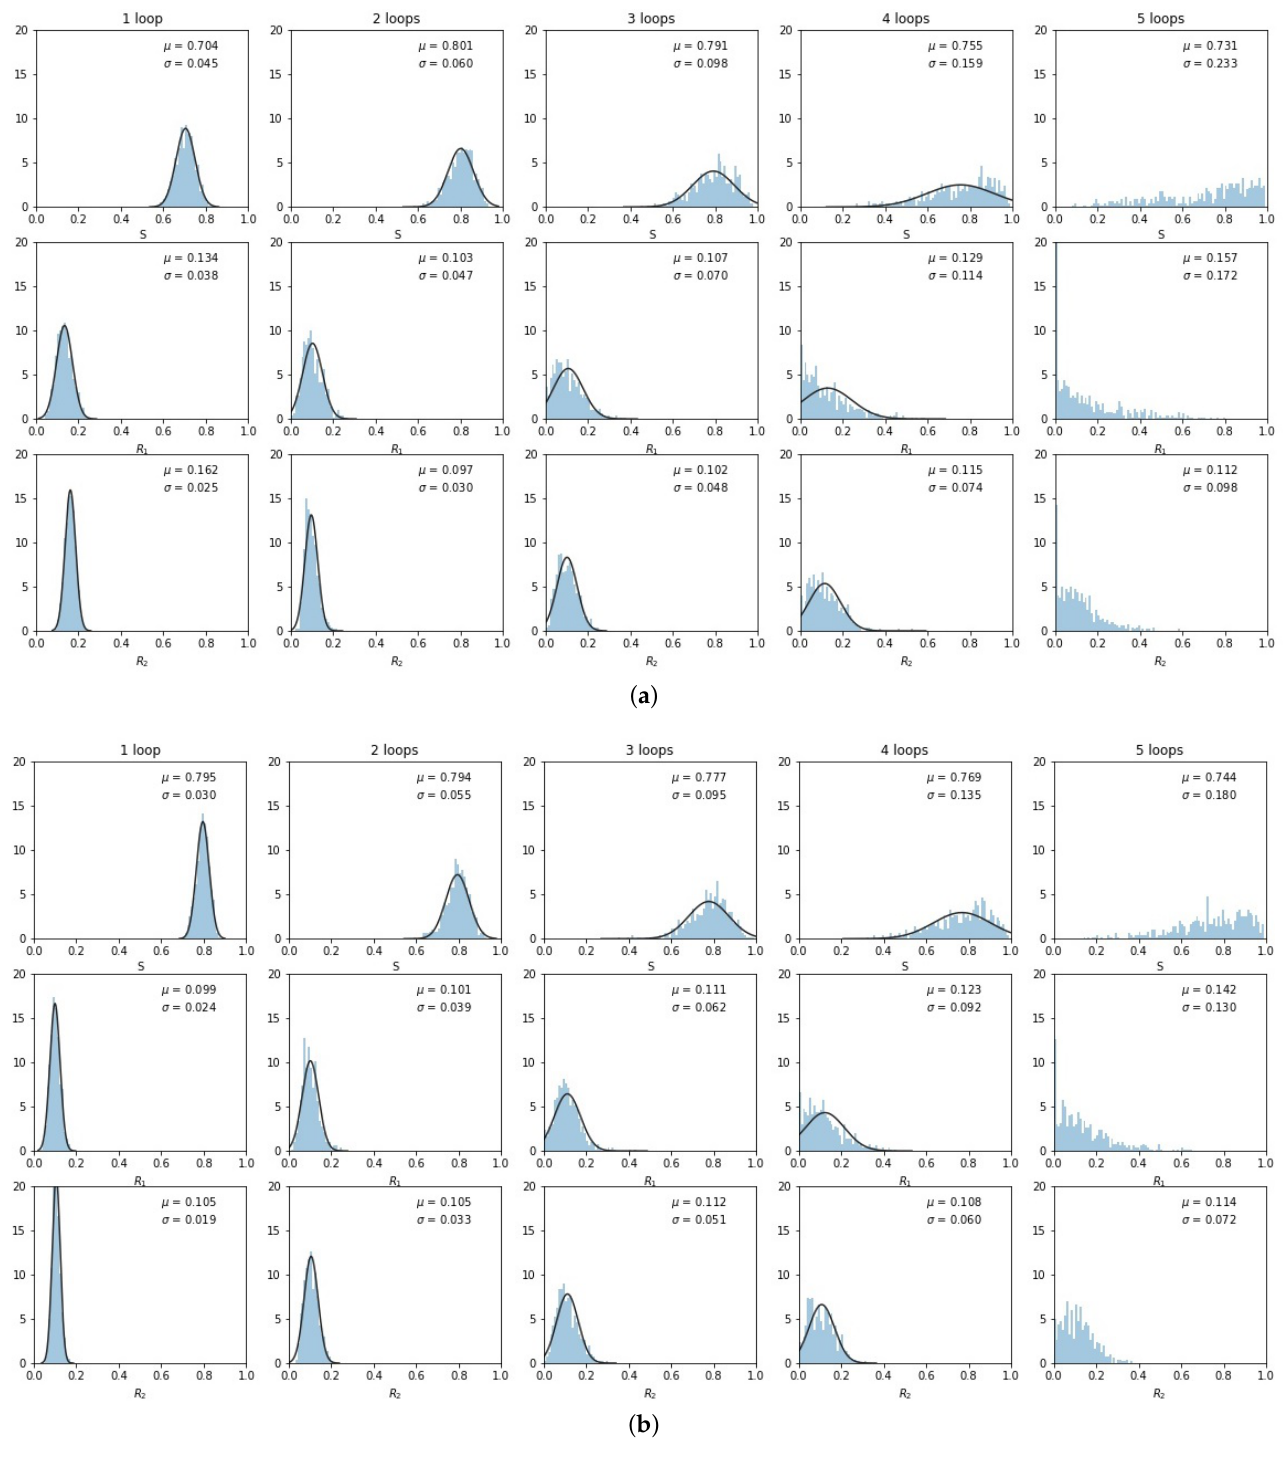
Figure 6. Same as Figure 5, but for synergistic e > 0 and antagonistic e < 0 drug interactions. ( a ) e = 0.3; ( b ) e = −